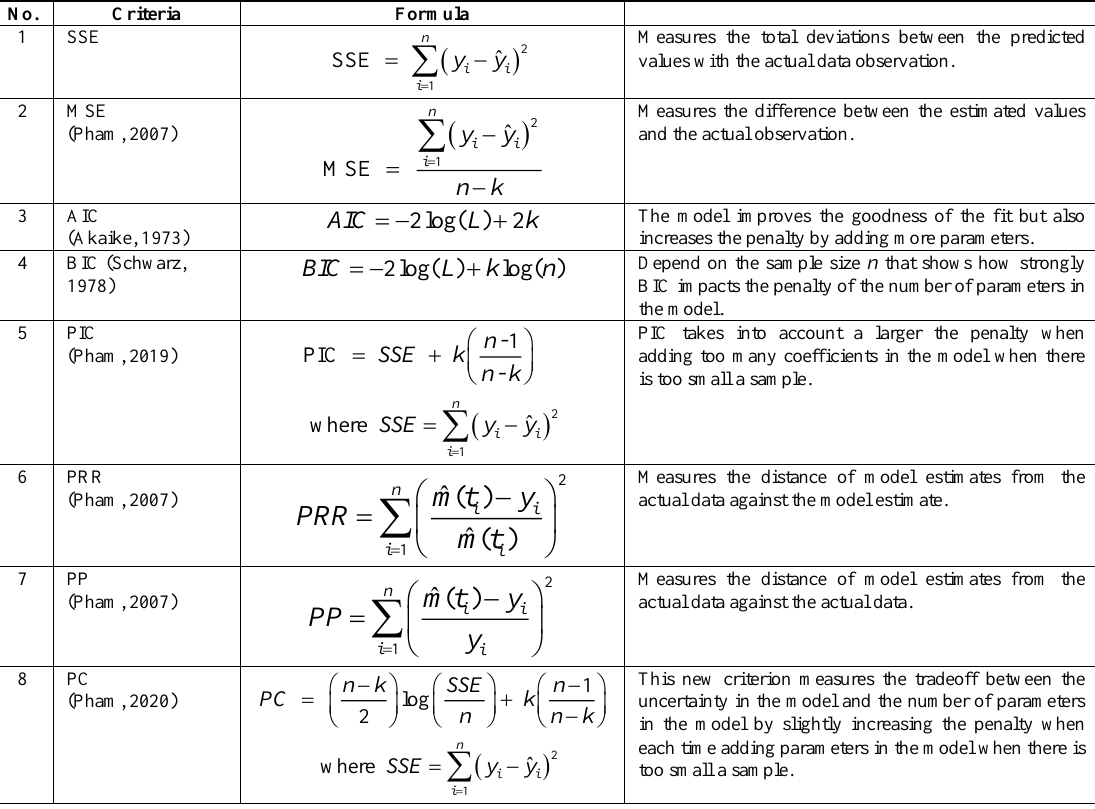
Table A. Some criteria model